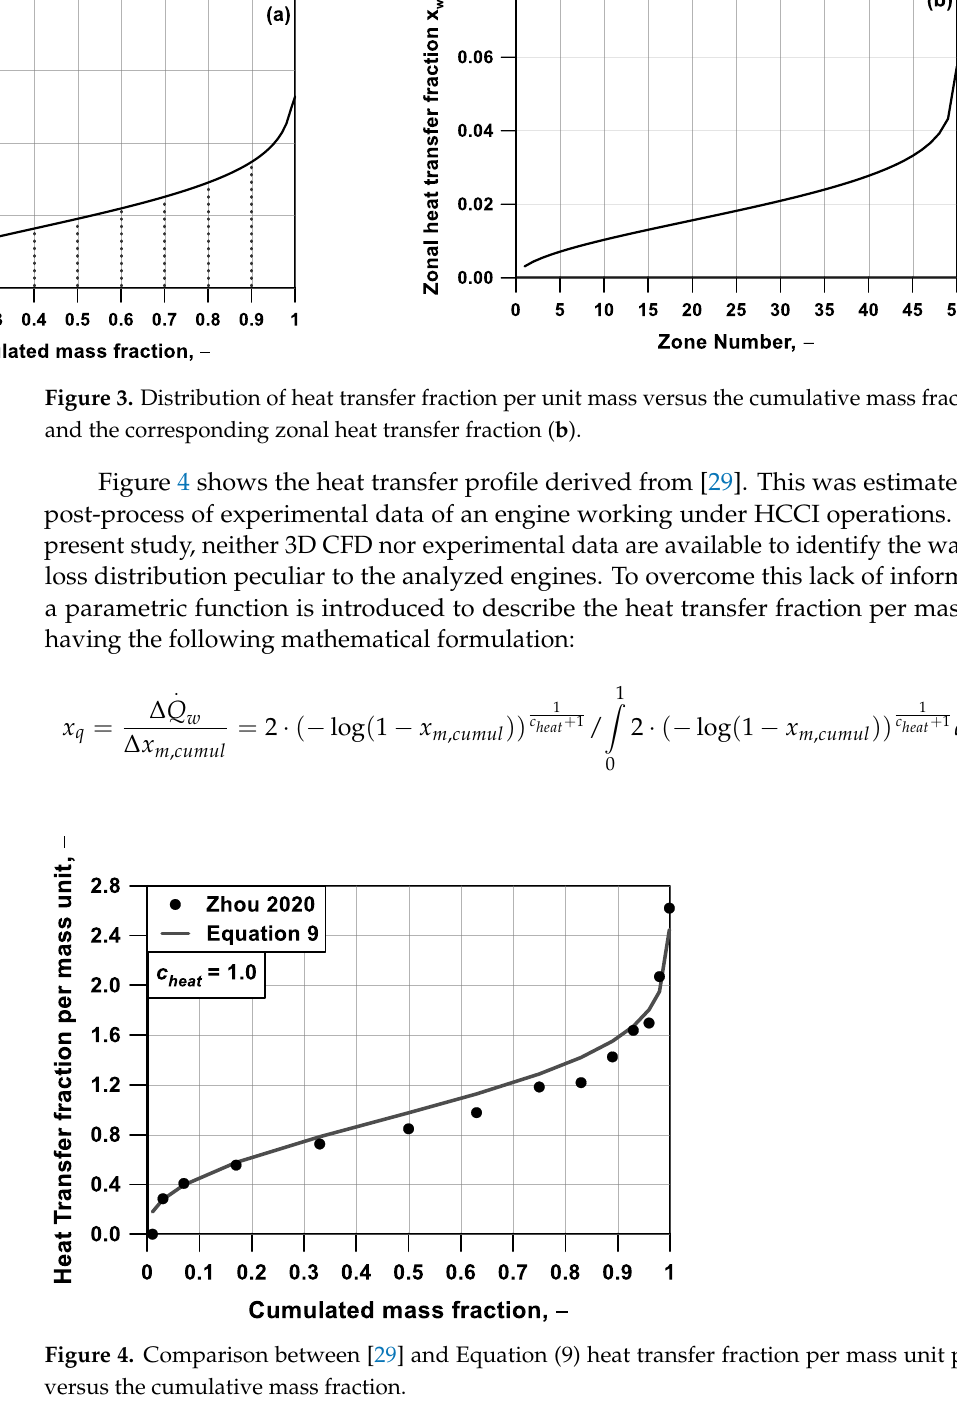
Figure 4. Comparison between [29] and Equation (9) heat transfer fraction per mass unit profiles versus the cumulative mass fraction.